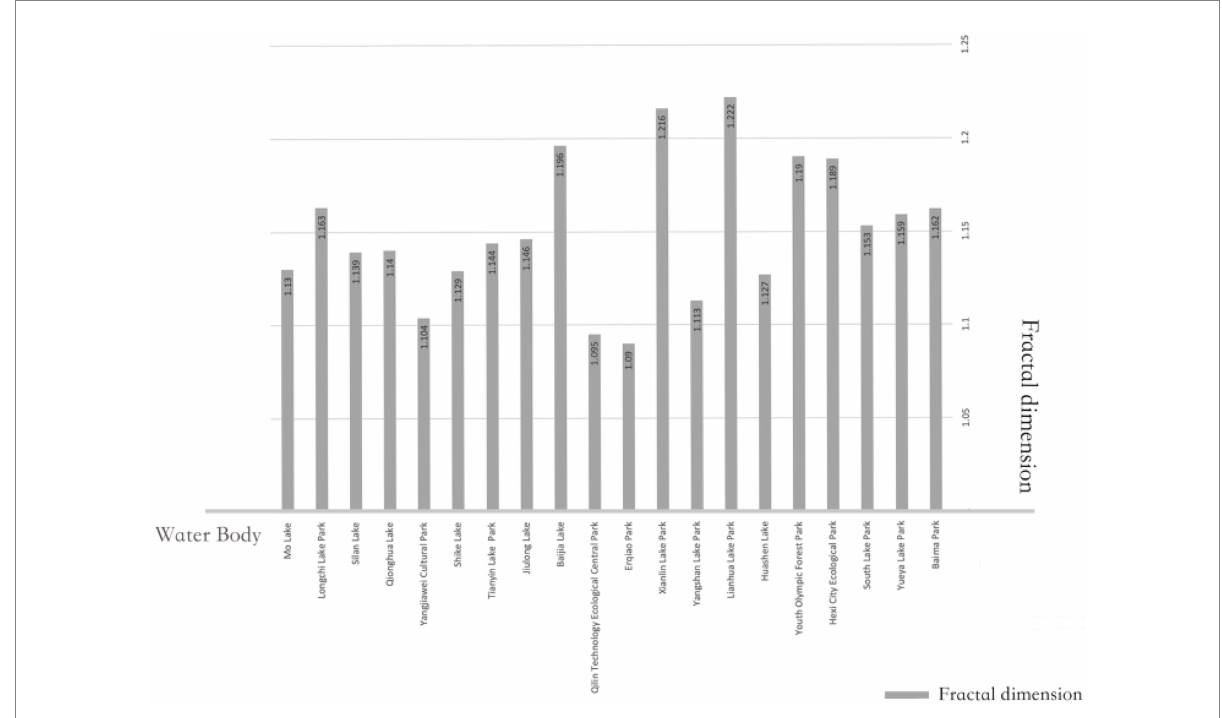
FIGURE 5 The fractal dimension statistics chart of modern public space water body.